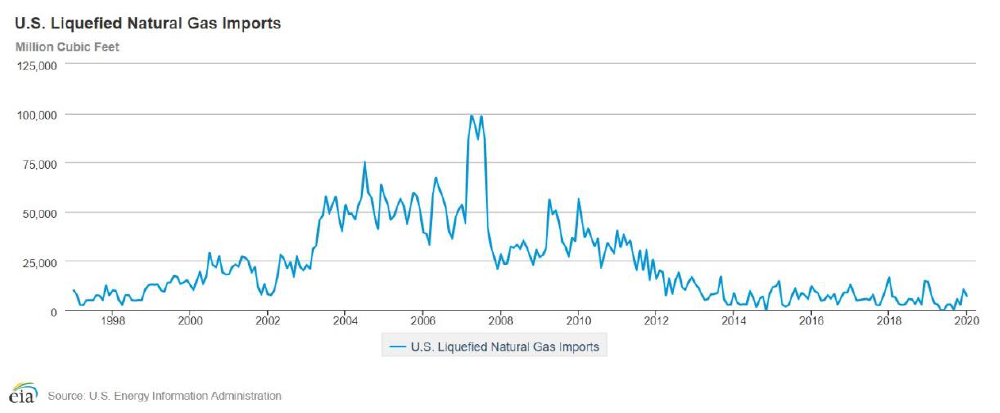
Figure 1. U.S. liquefied natural gas imports (1985–2020). Reproduced from U.S. Energy Information